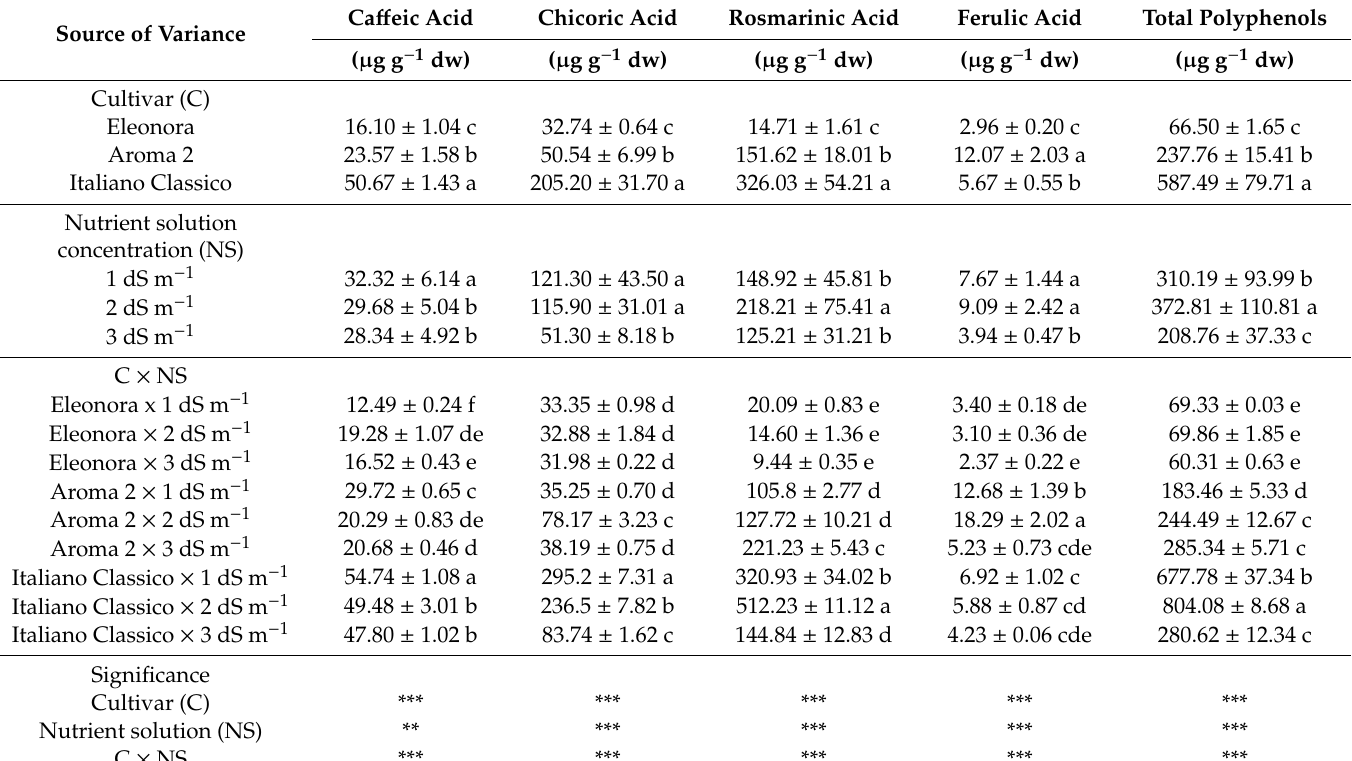
Table 4. Sweet basil phenolic acids profile in light of the cultivar and the nutrient solution electrical